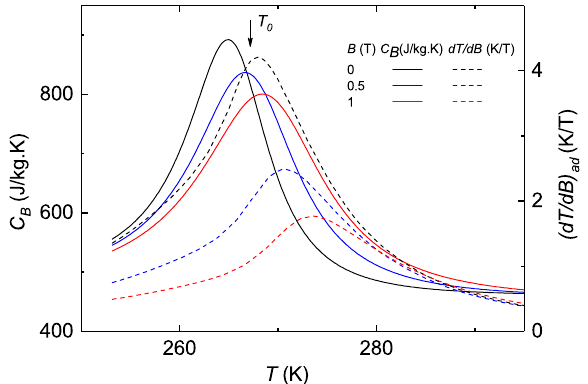
Figure 3. Heat capacity C B ( T ) and ( ∂ T / ∂ B ) ad of a La(Fe,Mn,Si) 13 H 1.65 alloy for B = 0, 0.5, and 1 T, and T 0 = 267.15 K. The arrow indicates the characteristic temperature T 0 . For other values of T 0 , all data are displaced correspondingly. These data were obtained from measurements in real alloys following the procedure described in